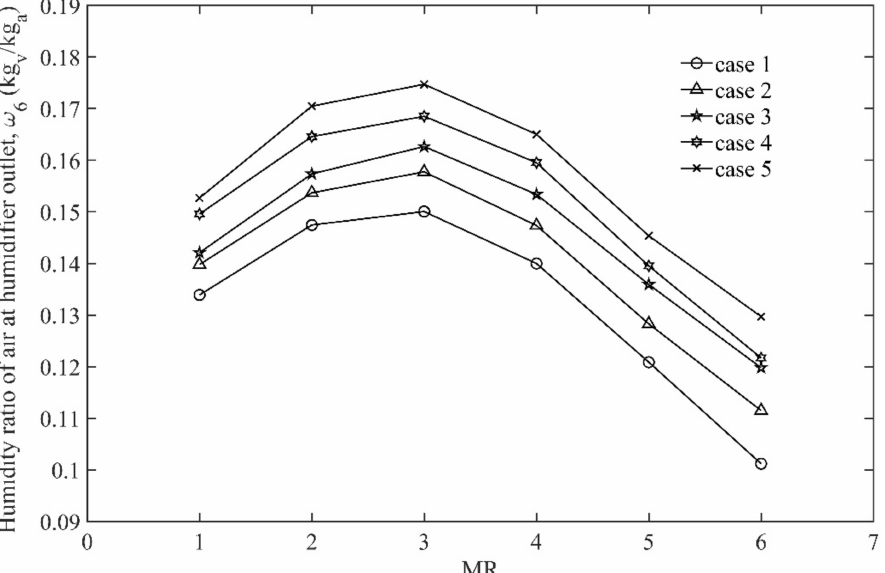
Figure 7. Humidity ratio of air across humidifier outlet for different MRs with relatable 90. The effect of the humidifier inlet water temperature on the specific thermal energy consumption rate (STEC) is depicted in Figure 8. It can be seen that at higher values of T 3 energy consumption was lower while at lower values of T 3 the STEC was very high.